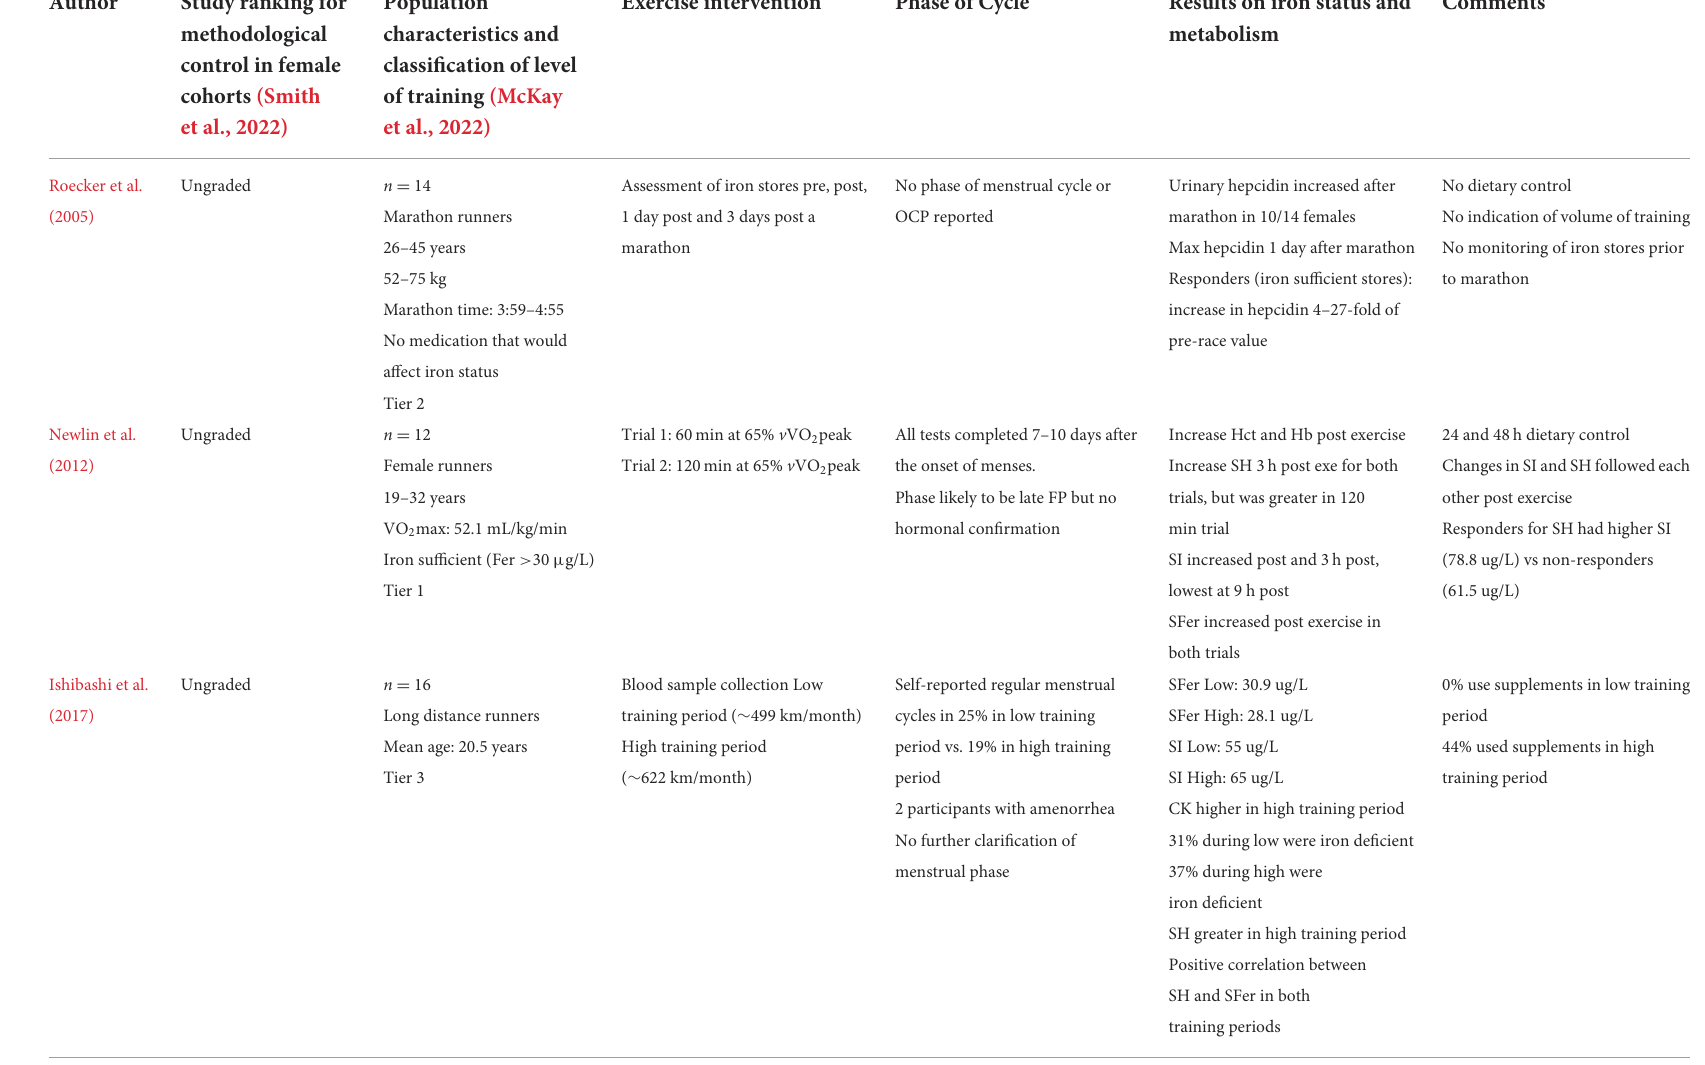
TABLE 2 Studies that have investigated iron status response pre and post exercise at various phases in the menstrual cycle in premenopausal